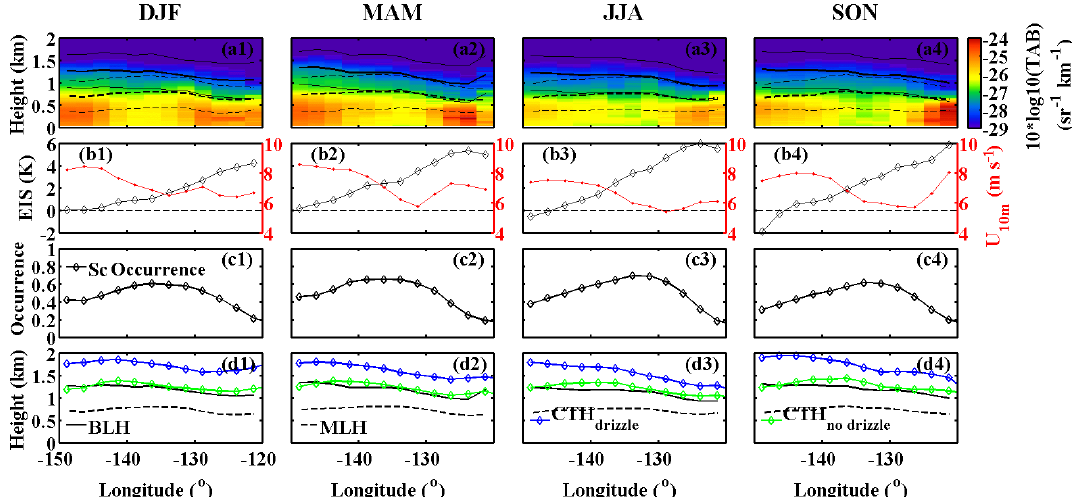
Figure 4. The satellite MBL observations along the transect region on the northeastern Pacific Ocean (NPO; solid box in Fig. 3e) in different seasons: (a1 – a4) the mean BLH (solid line) and MLH (dashed line) overlaid with TAB, and corresponding standard deviations (thin solid and dashed lines); (b1 – b4) EIS (black diamond line) and U 10m (red dot line); (c1 – c4) stratocumulus (Sc) occurrence; (d1 – d4) comparisons of BLH, MLH, CTH drizzle , and CTH nodrizzle